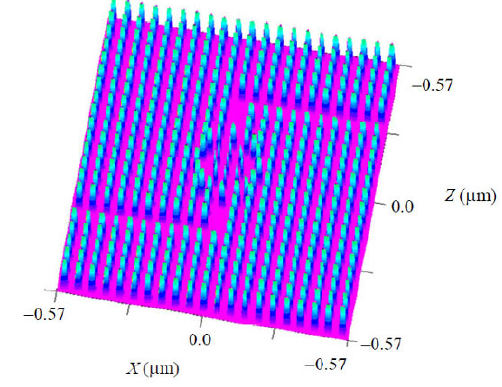
Fig. 3 3D view of the photonic crystal based biosensor.